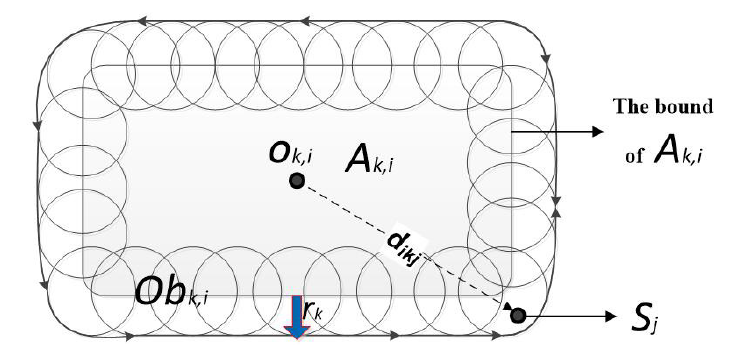
Figure 4. Obstacle area Ob k , i with the 2D